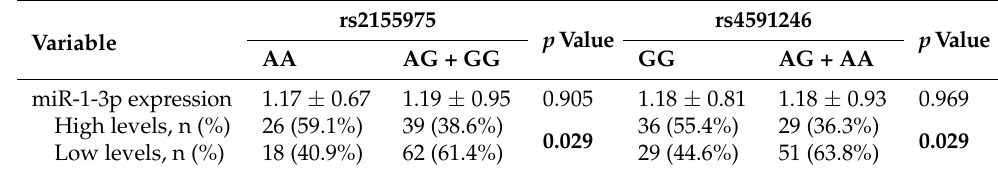
Table 5. Effects of rs2155975 and rs4591246 on the expression of serum miR-1-3p in AAA patients.